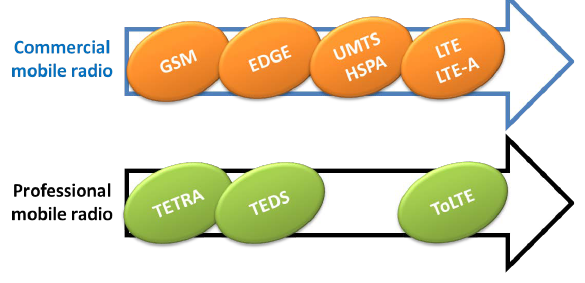
Figure 2. Terrestrial Trunked Radio (TETRA)